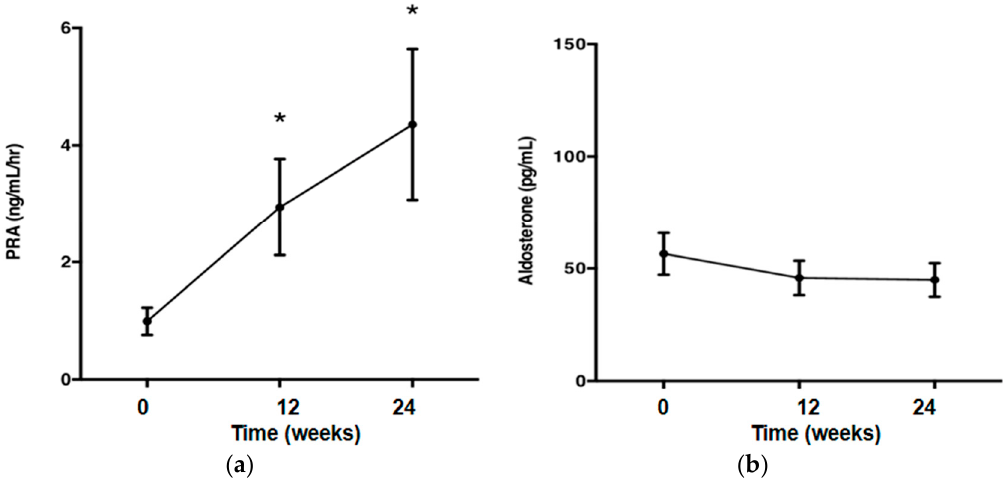
Figure 2. ( a ) Plasma renin activity was increased after the treatment with olmesartan; ( b ) treatment with olmesartan did not affect plasma aldosterone concentrations. One-way repeated measures ANOVA followed by Tukey’s multiple comparisons test were used to compare values over the time course. p < 0.05 was considered as statistically significant (* p < 0.05).